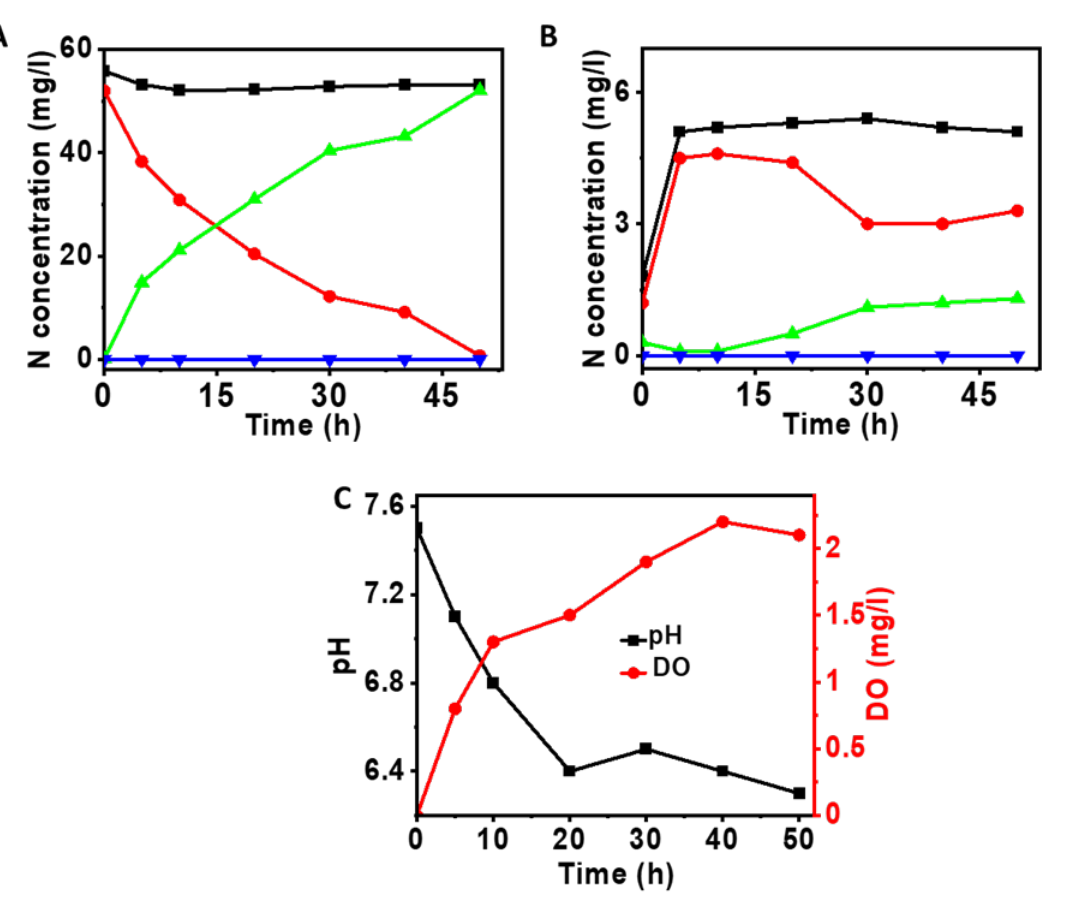
Figure 3. The variation in nitrogen (N) concentrations was noted at the anode ( A ) and cathode ( B ) of MEC by using 50 mg/L of ammonium nitrogen and 0.7 V. The total nitrogen (black squares), ammonium nitrogen (red circles), nitrate nitrogen (green up triangle), and nitrite nitrogen (blue down triangle). Changes in pH and DO ( C ) were noted at the anode of MEC during the nitrification process at an applied voltage of 0.7 V.